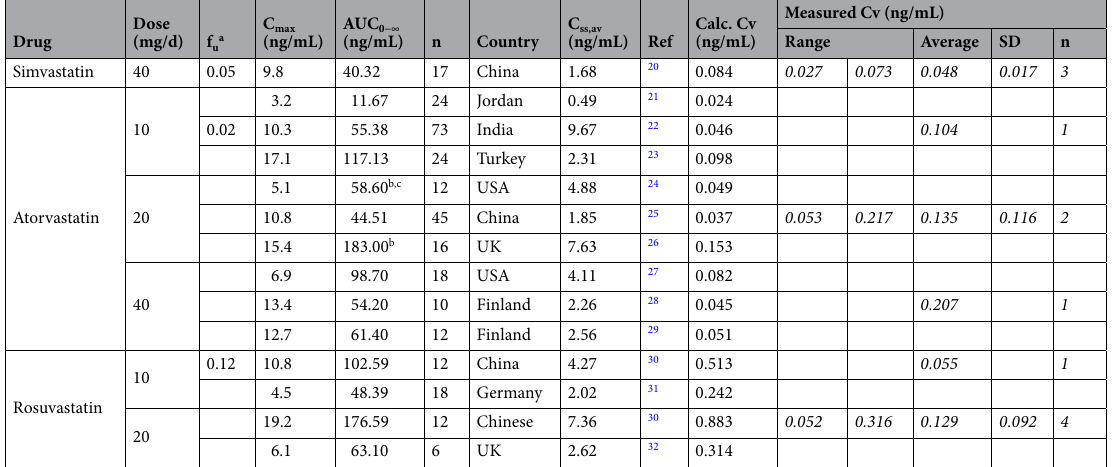
Table 2. Pharmacokinetic parameters from single-dose administration studies of oral statins, including calculated average concentration in plasma (C ss,av , using Eq. 1), and the corresponding expected vitreal concentrations (Calc. Cv, using Eq. 3). The measured C v range, average, standard deviation (SD) from patients measured in the present study on the same oral statin treatment. F u : free fraction of drug in plasma, C max : maximum drug concentration in plasma, AUC 0−∞ : area under the drug concentration curve from time 0 to infinity, n: number of participants in the clinical study. a From the summary of product characteristics document. b The analytical method to measure the concentrations of drug in the plasma samples was based on bioassay that may be inaccurate. c AUC from 0 to 24 h.